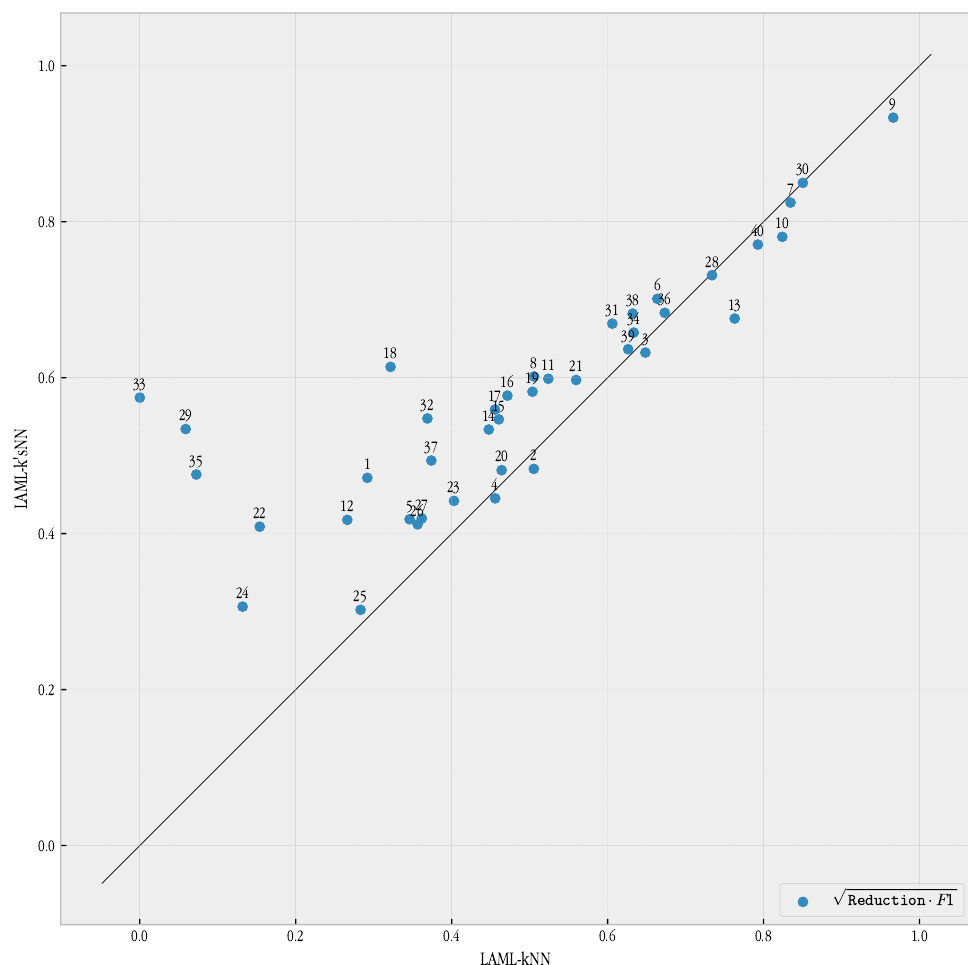
Figure 14. Results from LAML-kNN and LAML-k’sNN for the geometric mean of F1 and